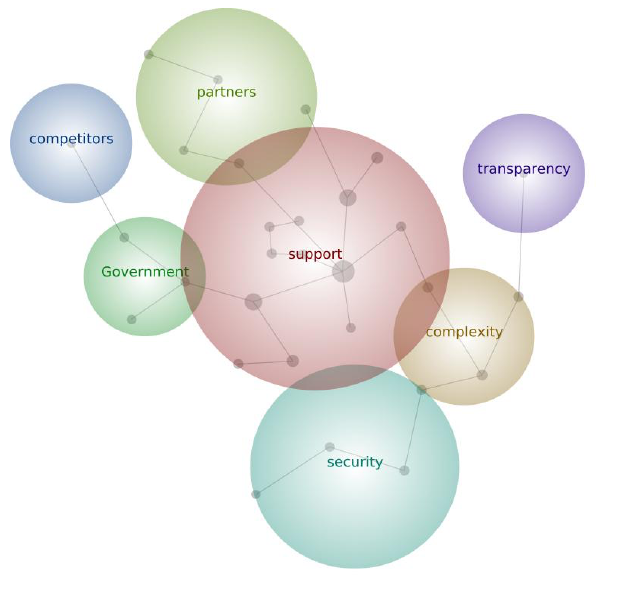
Figure 1: Blockchain Adoption Factors